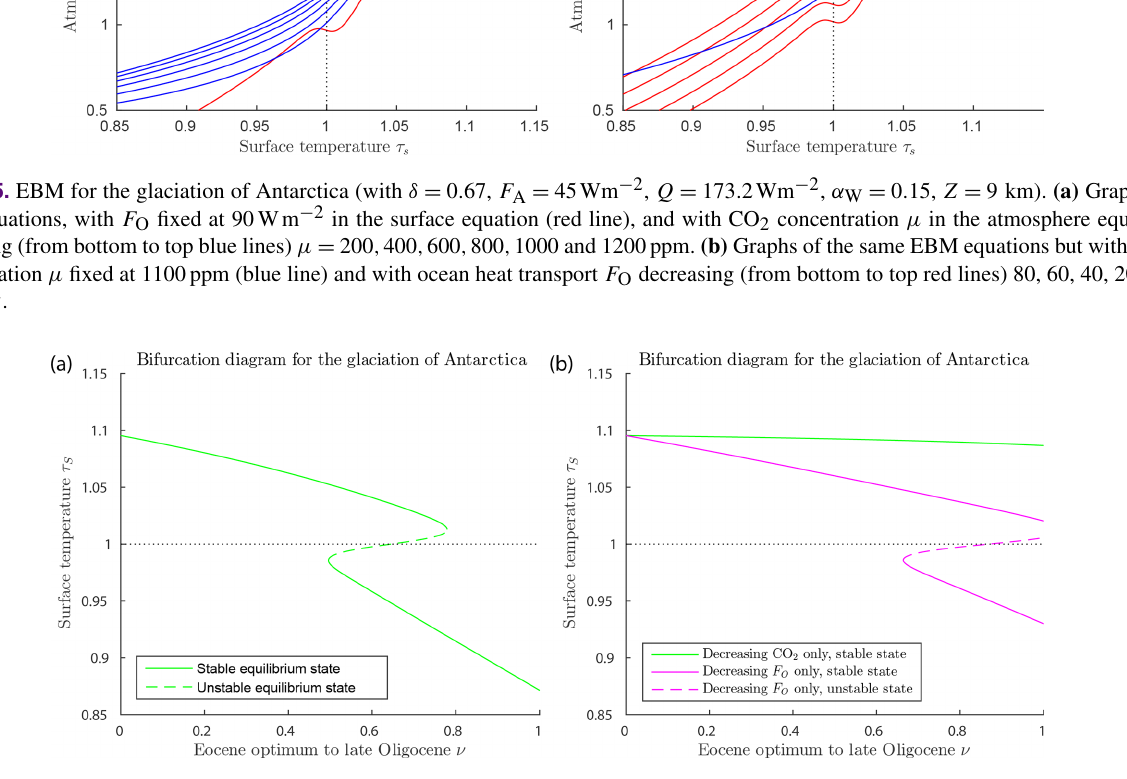
Figure 6. Bifurcation diagrams for the glaciation of Antarctica (with δ = 0 . 67, F A = 45, Q = 173 . 2Wm − 2 , α W = 0 . 15, Z = 9 km). (a) This shows a saddle-node bifurcation at ν = 0 . 779, corresponding to forcing parameter values µ = 555ppm and F O = 45 . 5Wm − 2 in Eq. (39). As ν increases through this saddle-node bifurcation point, the climate will transition abruptly from a warm state to a frozen state. The warm state and frozen state temperatures coexisting at the bifurcation point are + 3 . 5 and − 22 . 1 ◦ C. (b) Two superimposed bifurcation diagrams as in (a) , except that, on the green curve, F O is held fixed at its Eocene values while µ deceases as in Eq. (39), and, on the magenta curve, µ is held fixed at the Eocene value while F O decreases as in Eq. (39). No saddle-node bifurcation destroying the warm equilibrium occurs in either